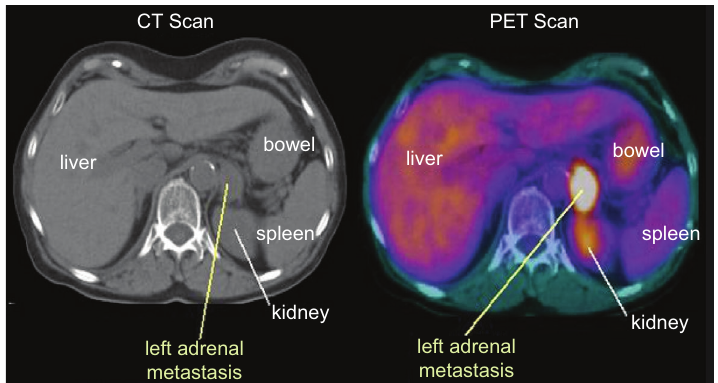
Figure 1: Computed tomography and positron emission tomography imaging showing adrenal gland metastasis.